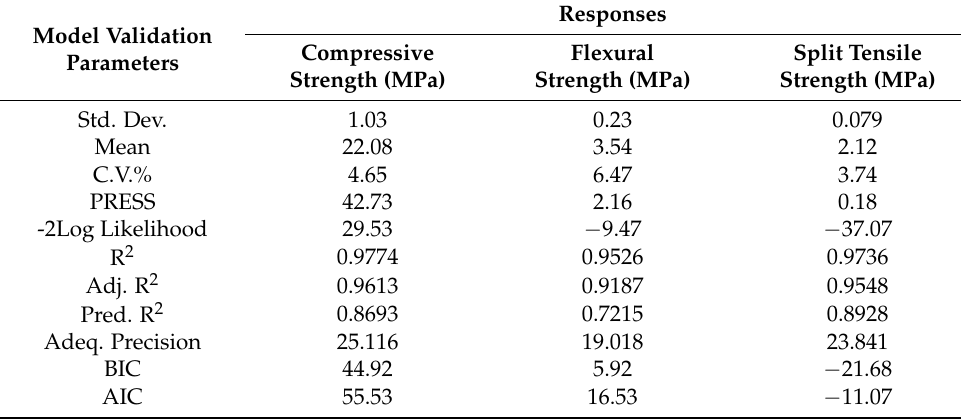
Table 5. Model validation parameters.